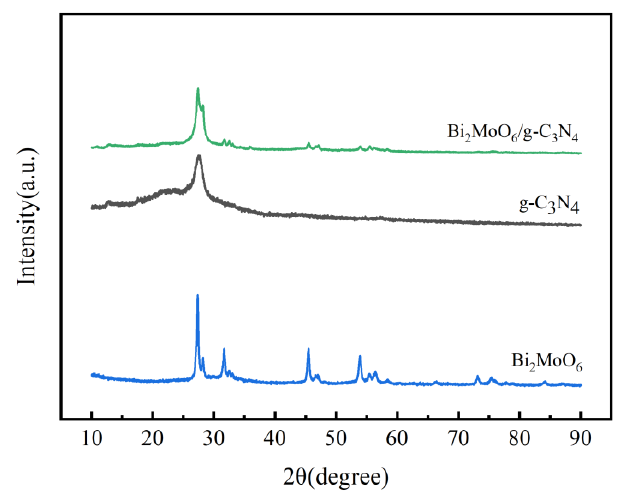
Figure 2. XRD pattens of g-C 3 N 4 , Bi 2 MoO 6 and 1:32 Bi 2 MoO 6 /g-C 3 N 4 . As shown in Figure 3, the FT-IR spectra of various ratios of Bi 2 MoO 6 /g-C 3 N 4 composites display notable absorption peaks around 810 cm − 1 , 1200–1700 cm − 1 , and 3200–3400 cm − 1 , which correspond to the absorption peaks of pure g-C 3 N 4 . The sharp absorption peak around 810 cm − 1 corresponds to the bending vibration of the 3-s-triazine ring, while multiple absorption peaks between 1200–1700 cm − 1 are attributed to the stretching and bending vibrations of C-N and C=N heterocycles. The broad absorption peak